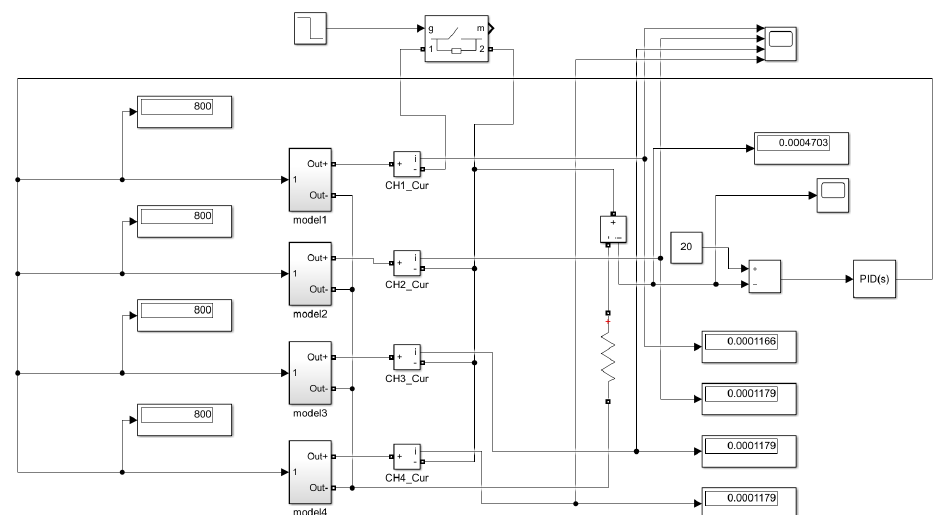
Figure 7. Simulink model of the 3 + 1 parallel redundant current source.